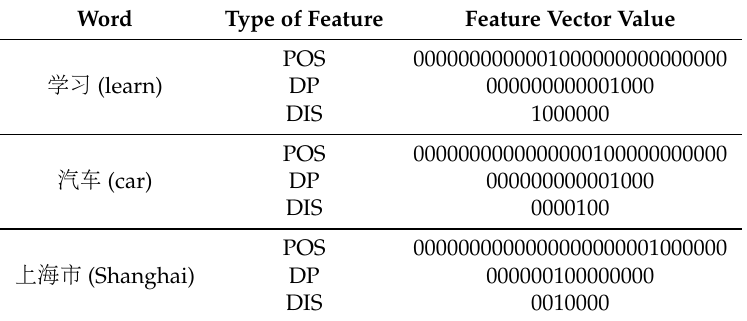
Table 2. Examples of feature